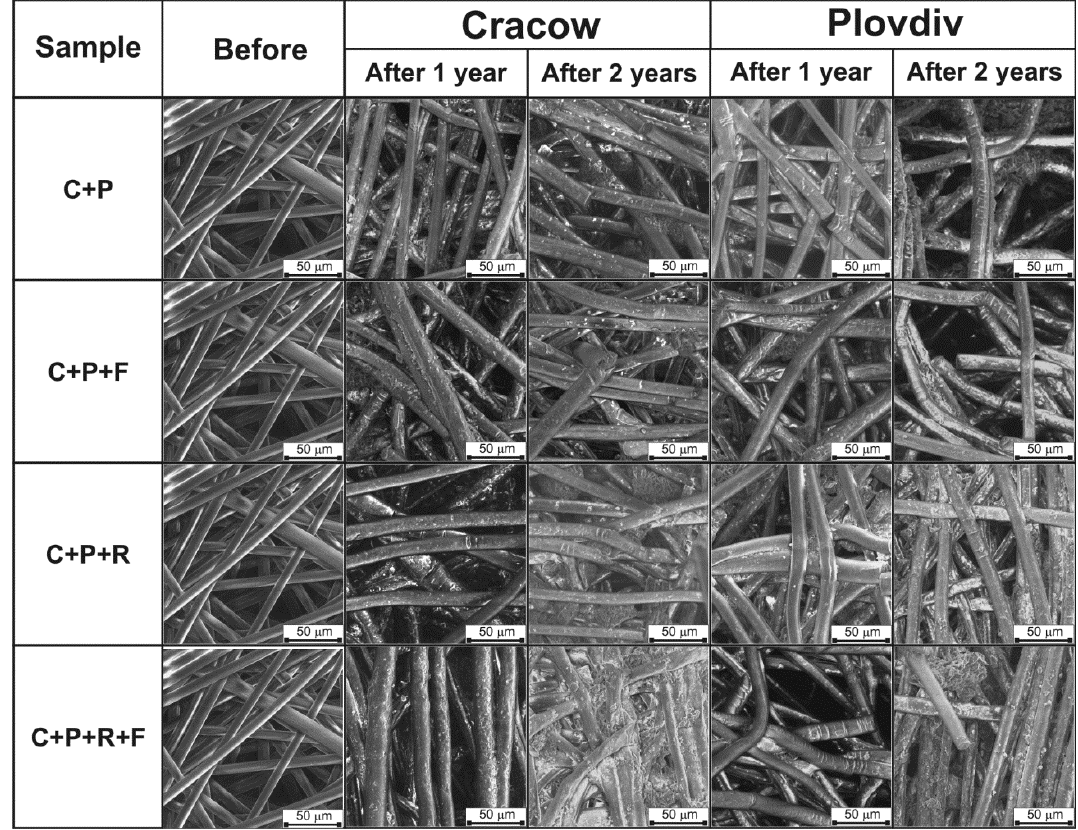
Figure 1. SEM images of PLA spun-bonded nonwovens before and after composting in various conditions.